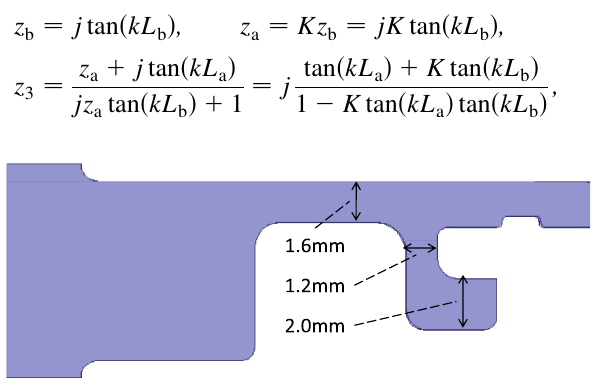
FIG. 11. Absorption curve of new choke (HFSS simulation).